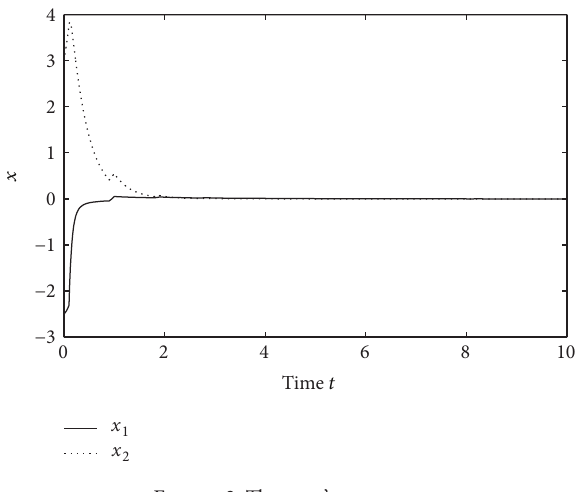
Figure 2: The state’s